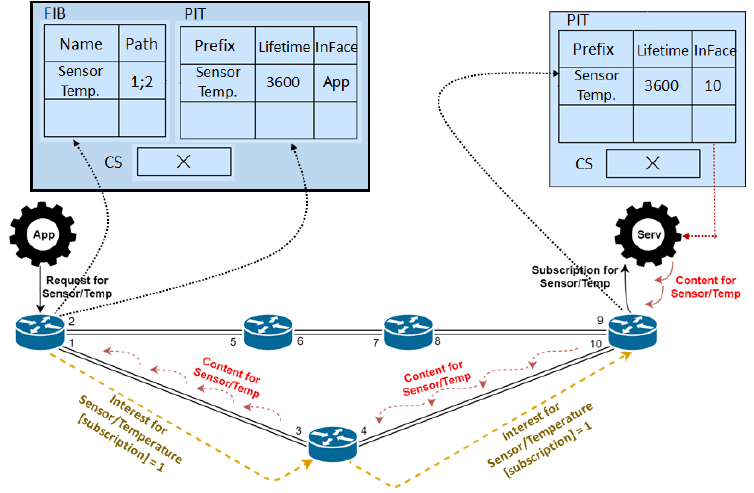
Figure 4. ndnIoT-FC pub-sub general